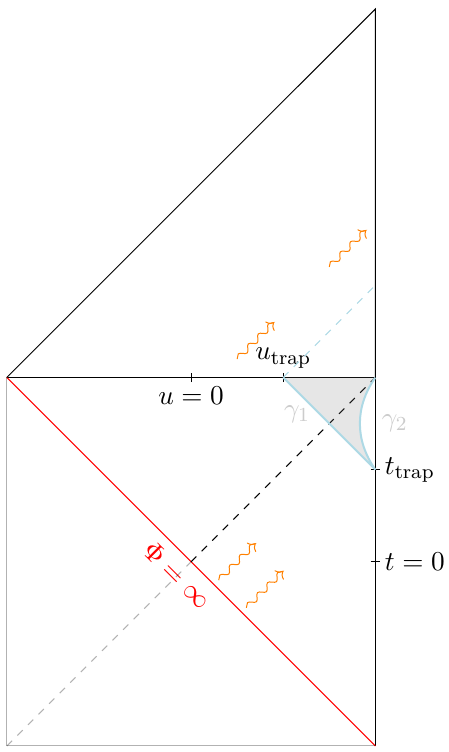
Figure 8 . The lower half of the Penrose diagram is de Sitter space; indicated in red is the past singularity. The upper triangle is Minkowski space, which we drew to indicate the effect of the trapped region (shaded in gray) on what the meta-observer can see. The observer inside the static patch can collect radiation up to the Page time t Page = t trap , at which time the trapped region forms. Similarly, the meta-observer can see radiation from before u trapped